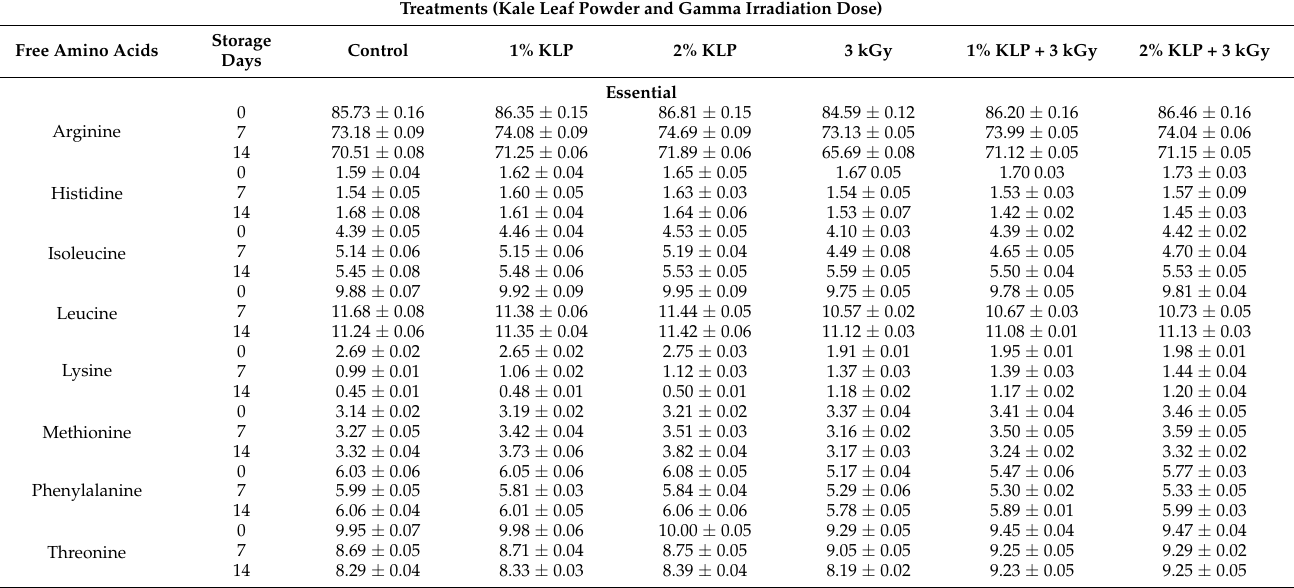
Table 2. Free amino acid composition (mg/100 g) of chicken meat treated with kale leaf powder and gamma irradiation at different storage